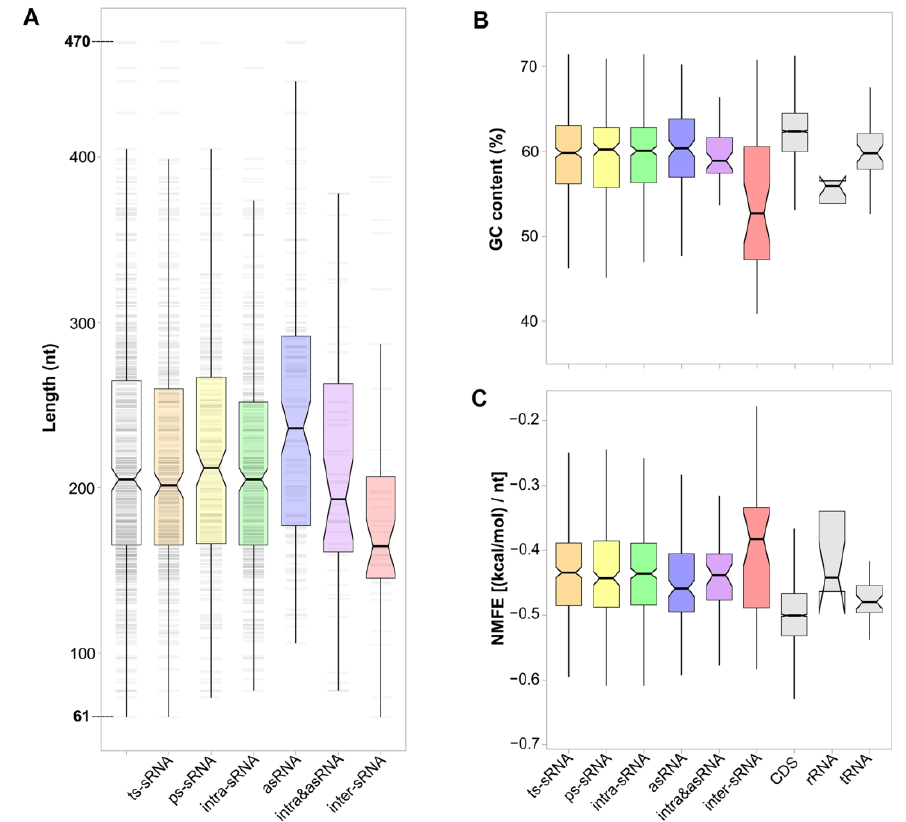
Figure 3. Sequence and structure features of sRNAs with different classifications. ( A ) Boxplot shows the length distributions of different types of sRNAs. The grey stripes in the background shows the overall length distributions. ( B ) GC contents and ( C ) NMFEs of classified sRNAs, CDSs, rRNAs and